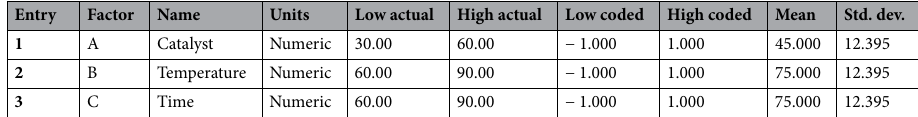
Table 4. Actual and coded forms of the designed experiments with the factors in CCD.